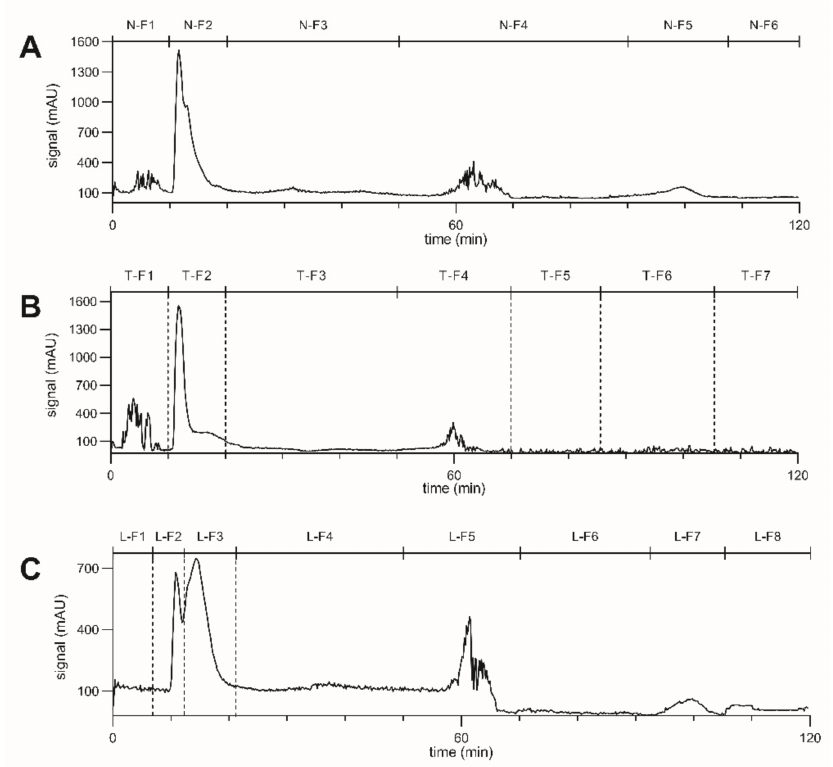
Figure 1. Chromatograms at 254 nm from CPC fractionations with Waltheria indica leaf extract and Arizona liquid system with ( A ) solvent composition N, ( B ) solvent composition T and ( C ) solvent composition L. The elution step lasted for 50 min initially, followed by an extrusion step. Fractions highlighted with dashed lines were further analyzed by